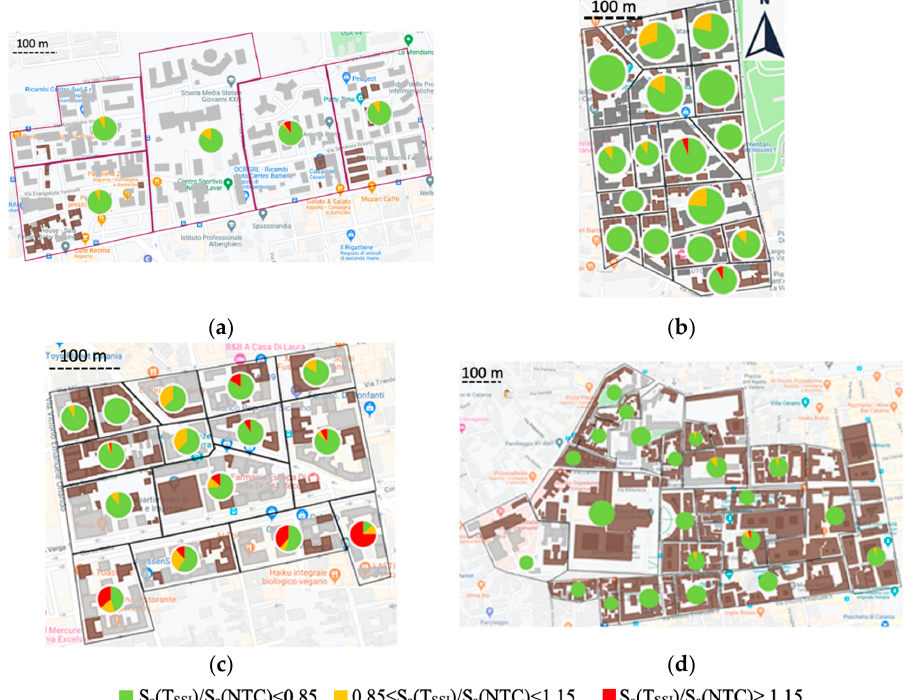
Figure 20. Spatial distribution of S a (T SSI )/S a (NTC2018) ratios for the 1818 seismic input: ( a ) west area; ( b ) northeast area; ( c ) north Old Town; ( d ) south Old Town. Geosciences 2020 , 10 , x FOR PEER REVIEW